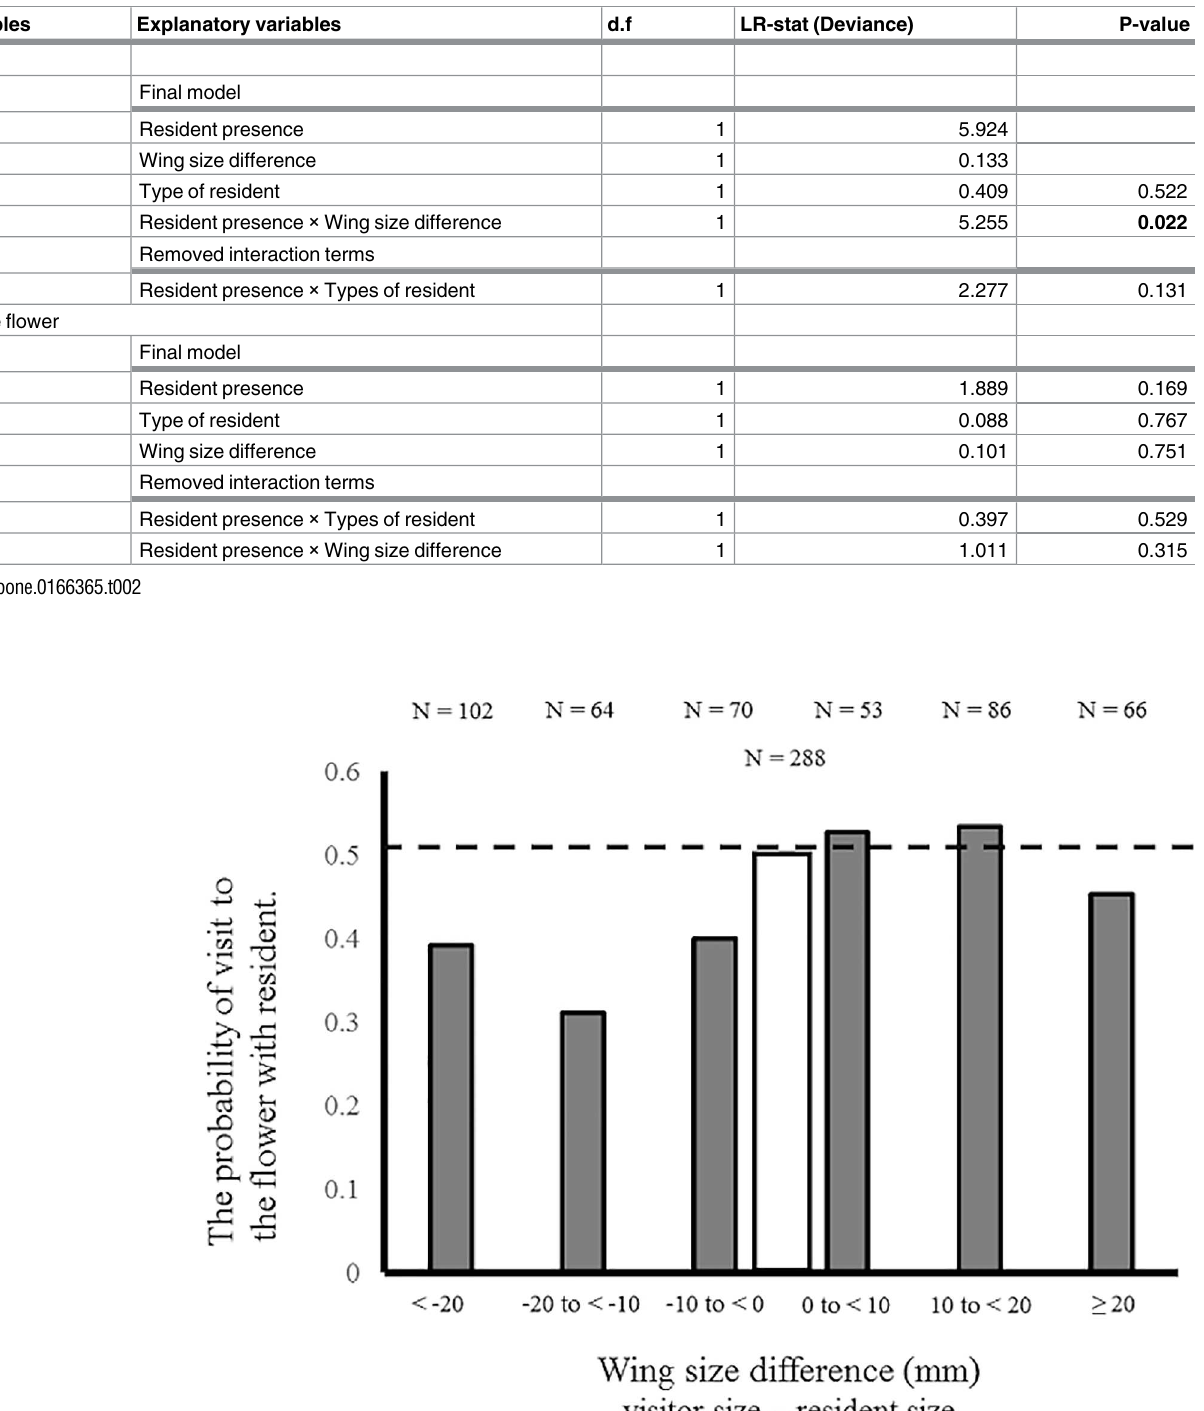
Table 2. Effects of presenceof resident butterfly, type of resident butterfly (conspecific or heterospecifics with visitor), wing size difference between visitor and resident butterfly species and the interactions on the visit choice and the time spent on the flower.